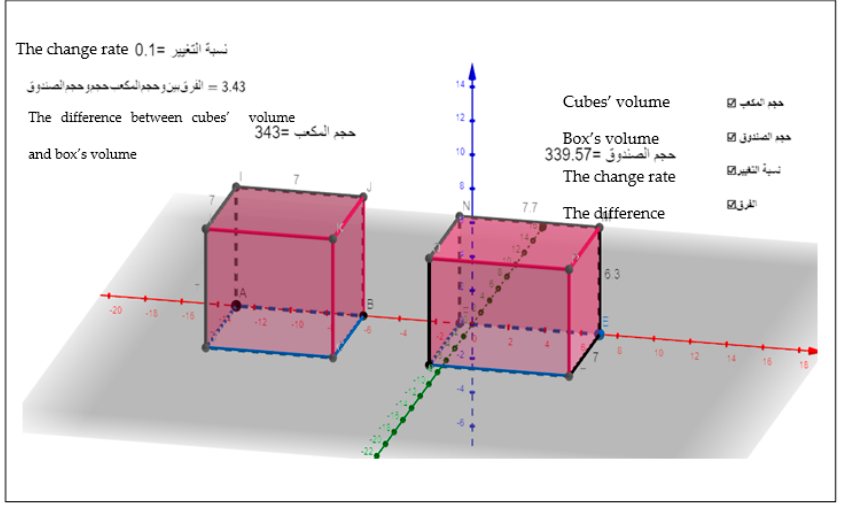
Figure 4. Applet reveals the intuitive error-dynamic referent in volume.